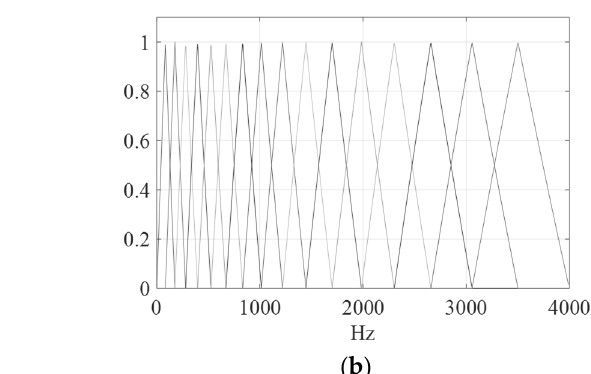
Figure 1. Spectrograms constructed using different window lengths; left 10 ms, right 30 ms.